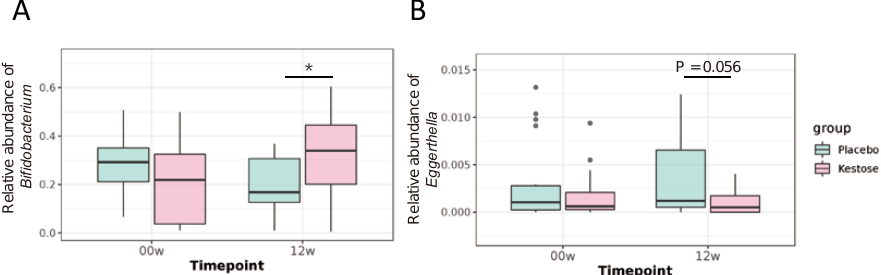
Figure 3. The relative abundance of Bifidobacterium increased in the kestose group after the 12-week intervention. ( A ): The relative abundance of genus Bifidobacterium was expressed as the median with the interquartile range at baseline and Week 12. ( B ): The relative abundance of genus Eggerthella was expressed as the median with the interquartile range at baseline and Week12. ( A , B ) were assessed for statistical significance using the Kruskal-Wallis test. * p <